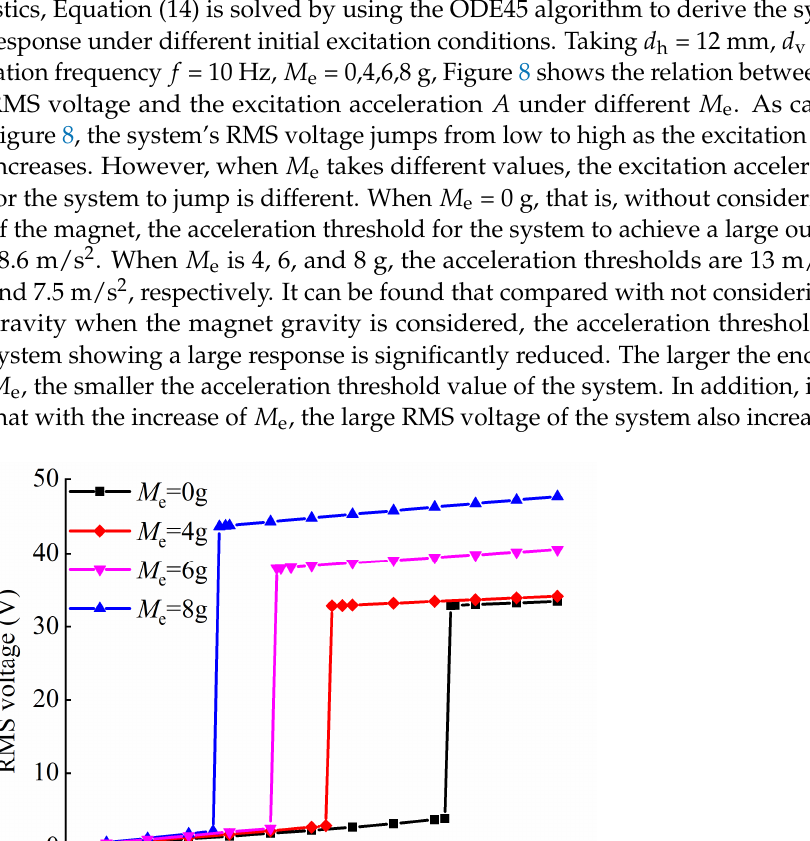
Figure 7. System’s potential energy curve under different   .